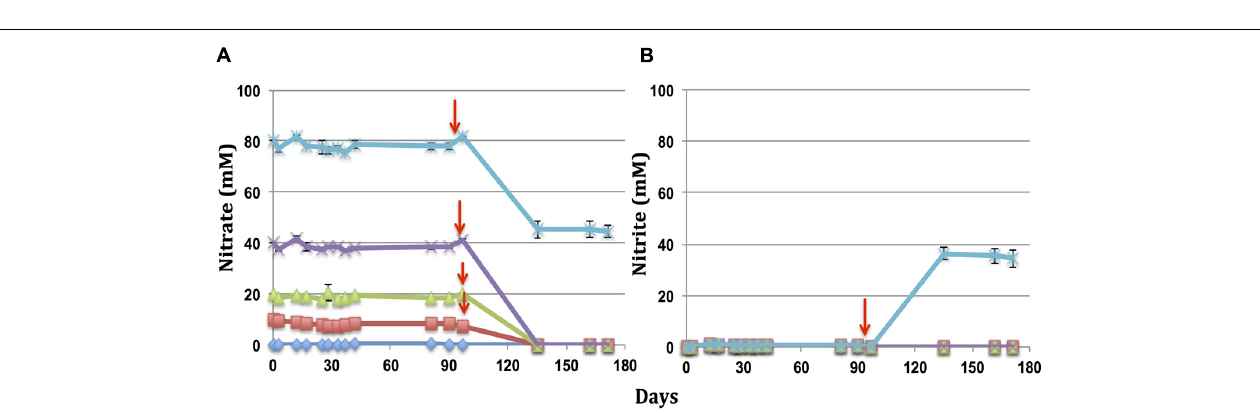
FIGURE 5 | Gas chromatography-mass spectrometry analysis of the oils, (A) PNG and (B) Tundra extracted from the incubations of oil field hNRB with nitrate and oils at the end of incubation period of 90 days. The presence of alkylbenzenes is represented as the ratio of peak areas of a particular alkylbenzene to mesitylene (1,3,5-trimethylbenzene). Note the difference in scale. Error bars represent standard deviations for duplicate measurements.